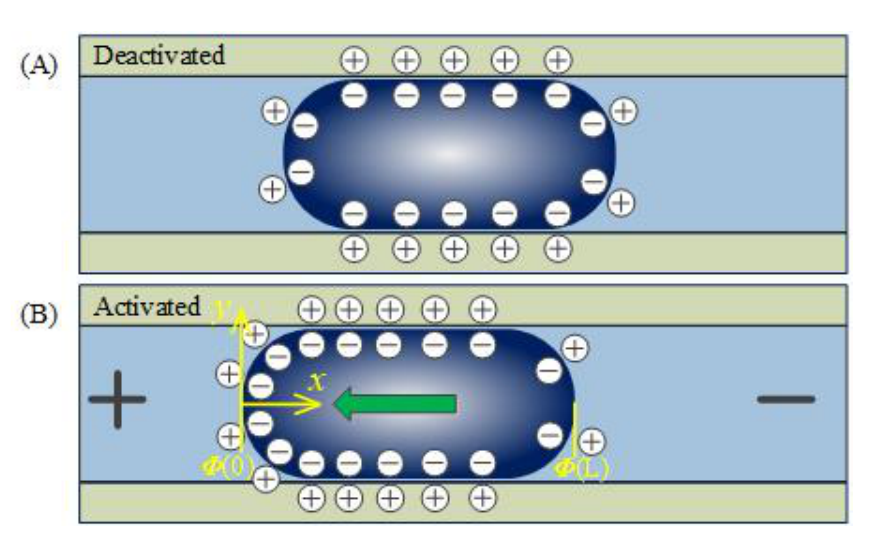
Figure 2. Working mechanism of the continuous electrowetting actuation of galinstan liquid metal. ( A ) Schematic of the charge distribution over the liquid metal surface when immersed in the NaOH solution. ( B ) Schematic of the surface charge distribution and transportation direction of the liquid metal upon the application of external electrical field.